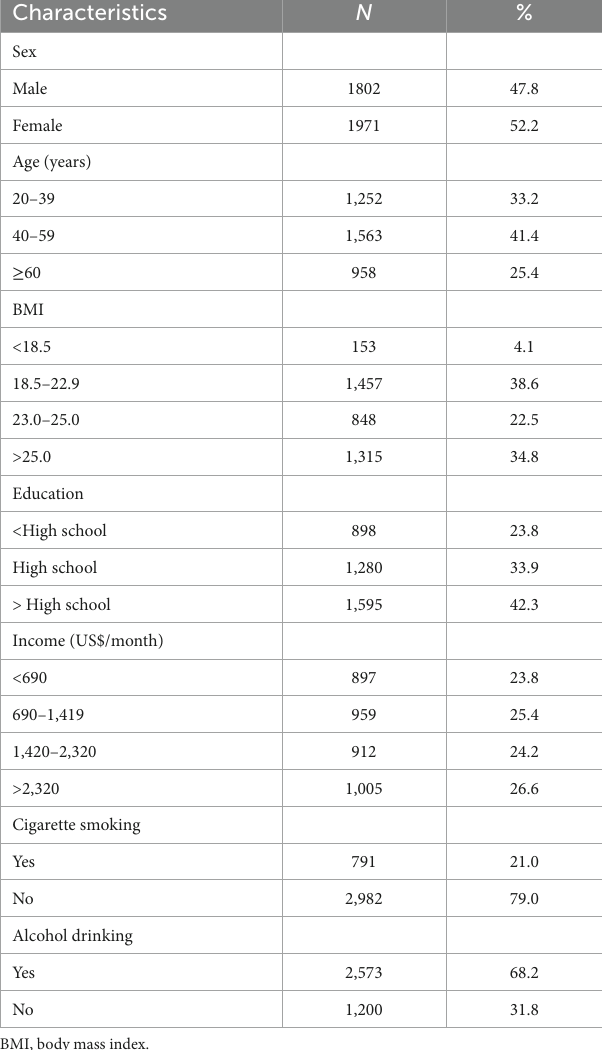
TABLE 1 Demographic characteristics of the study participants. TABLE 2 Blood Hg concentrations by demographic characteristics in Korean adults aged ≥ 20